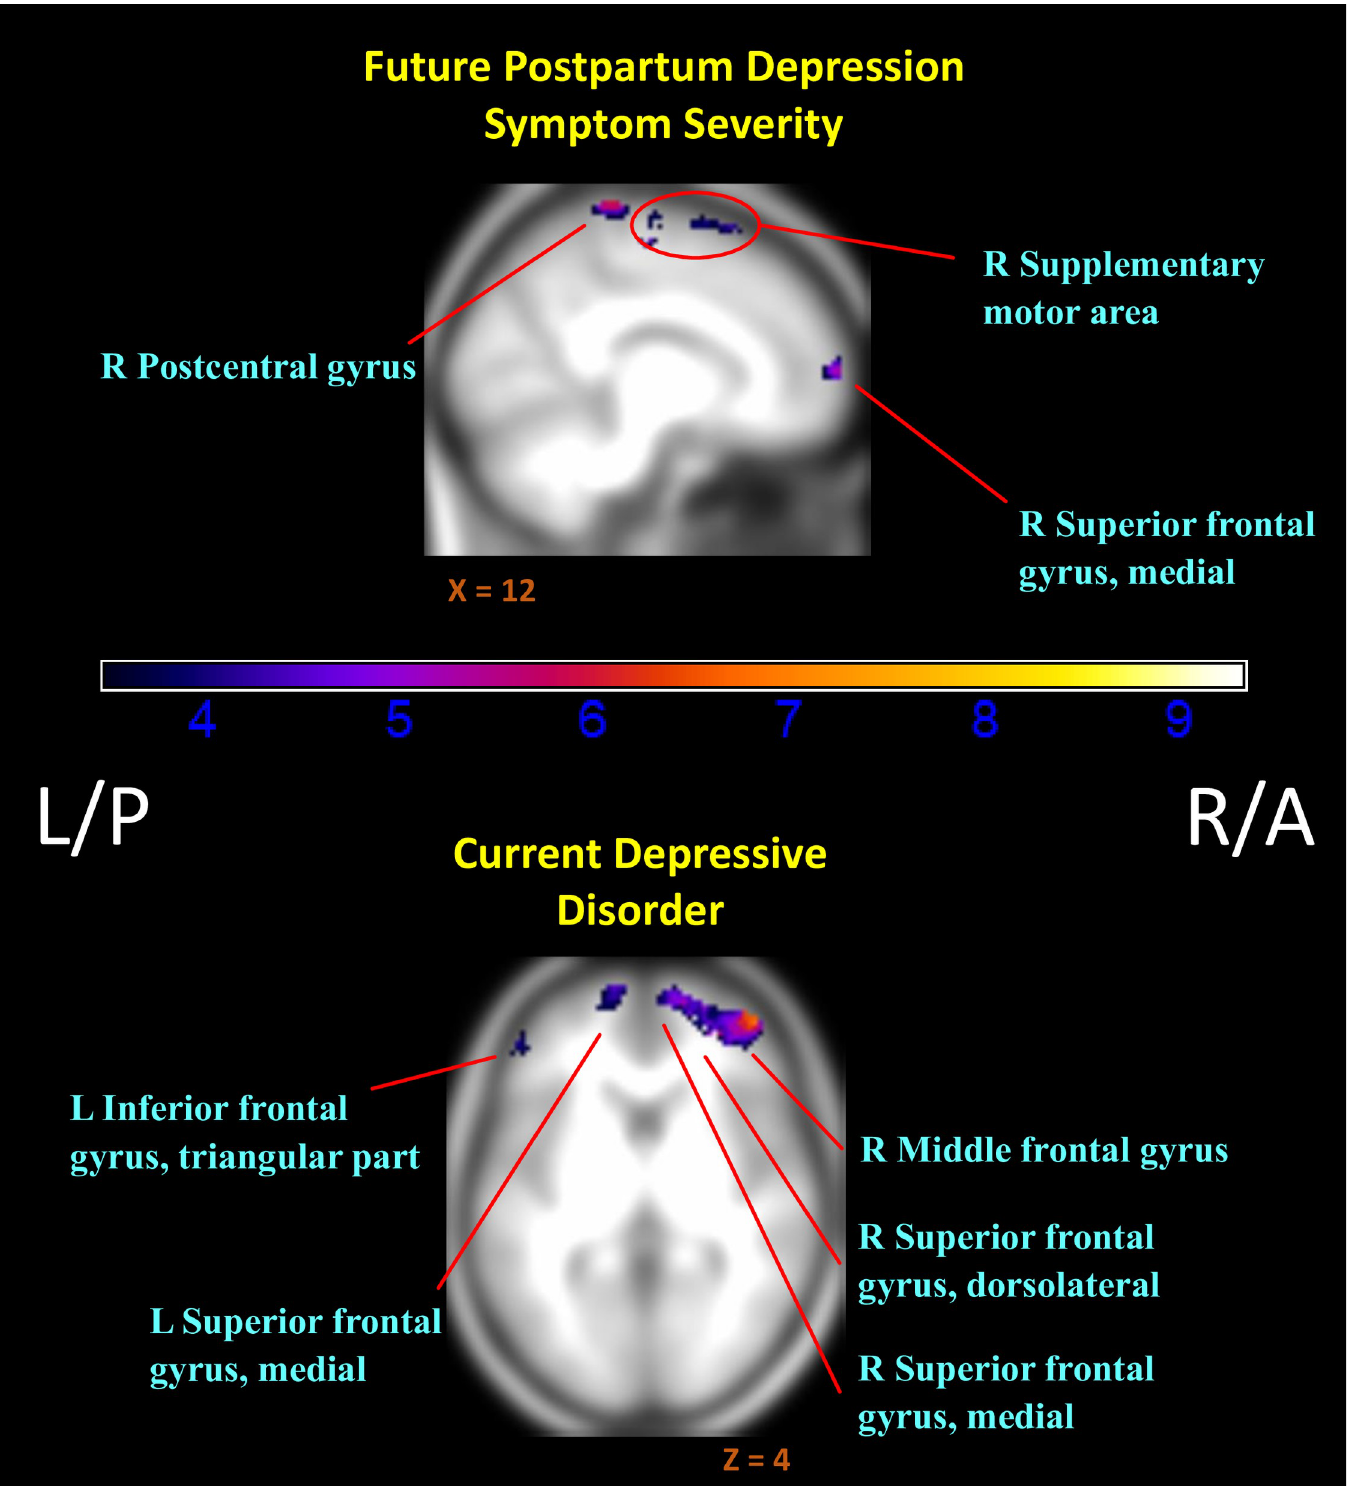
Fig 2. Regions of reduced activation to positive versus negative infant emotion tasks with increasing markers of depression. ( i . e . Negative associations of (InfOwnPos > InfOwnNeg) with CESD[T1-T4] & Dep-Dx. Anatomical labels added for reference are taken from the AAL atlas , but do not represent an exhaustive list of cluster extent . Activation overlaid on smoothed (8mm Gaussian kernel) average of subject anatomical images . Past episodes of depression did not relate to differential responding for this contrast . https://doi.org/10.1371/journal.pone.0250487.g002 PLOS ONE | https://doi.org/10.1371/journal.pone.0250487 April 27,